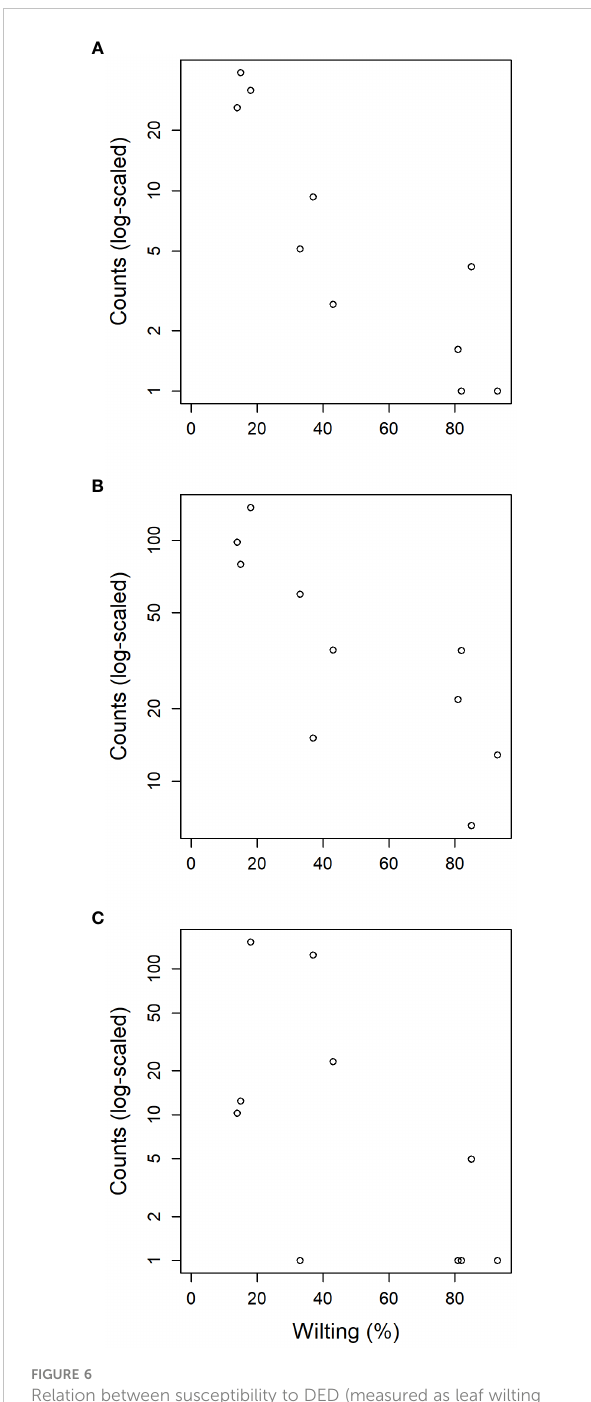
FIGURE 6 Relation between susceptibility to DED (measured as leaf wilting percentage) of the ten clonal bank genotypes and the normalized counts detected from reads of endophytic fungal families (A) Buckleyzymaceae, (B) Trichomeriaceae and (C)